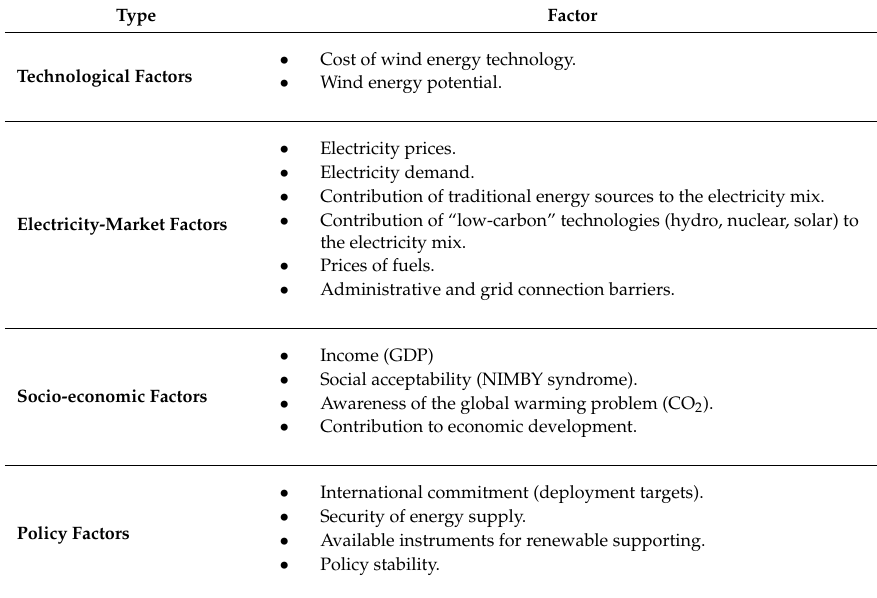
Table 2. Factors determining the increase in wind installed